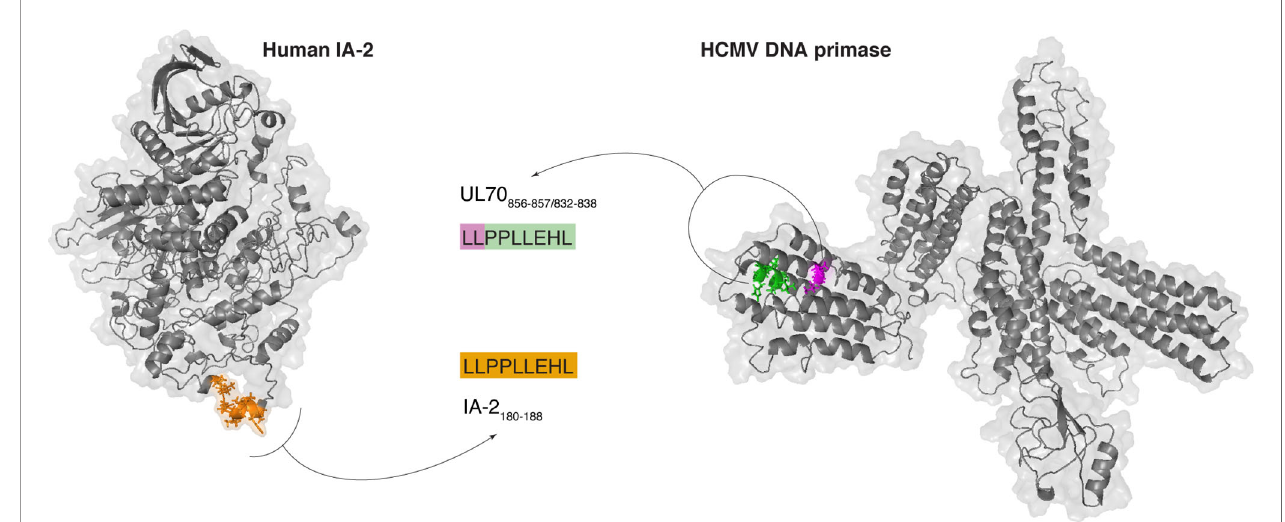
FIGURE 3 | Example of potentially immunogenic zwitter viral cis -spliced/human non-spliced peptide. Predicted crystal structure of the human IA-2 (a.k.a. PTPRN) and HCMV DNA primase ( UL70 ) and theoretical localization of the viral-human zwitter peptide candidate LLPPLLEHL. This peptide may be generated through peptide hydrolysis from human IA-2 and through peptide splicing from HCMV DNA primase. The zwitter non-spliced peptide candidate IA-2 180-188 [LLPPLLEHL] is depicted in orange. For the zwitter cis -spliced peptide candidate UL70 856-857/832-838 [LL][PPLLEHL], the two splice-reactants are depicted,